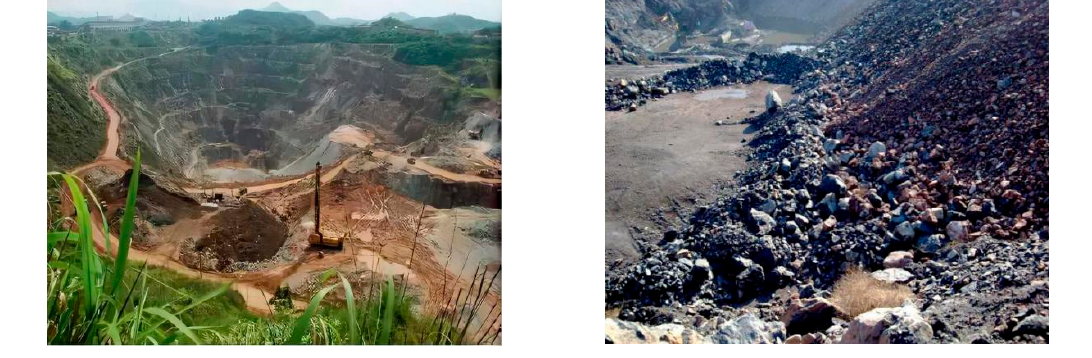
Figure 1. Open pit ore mining.